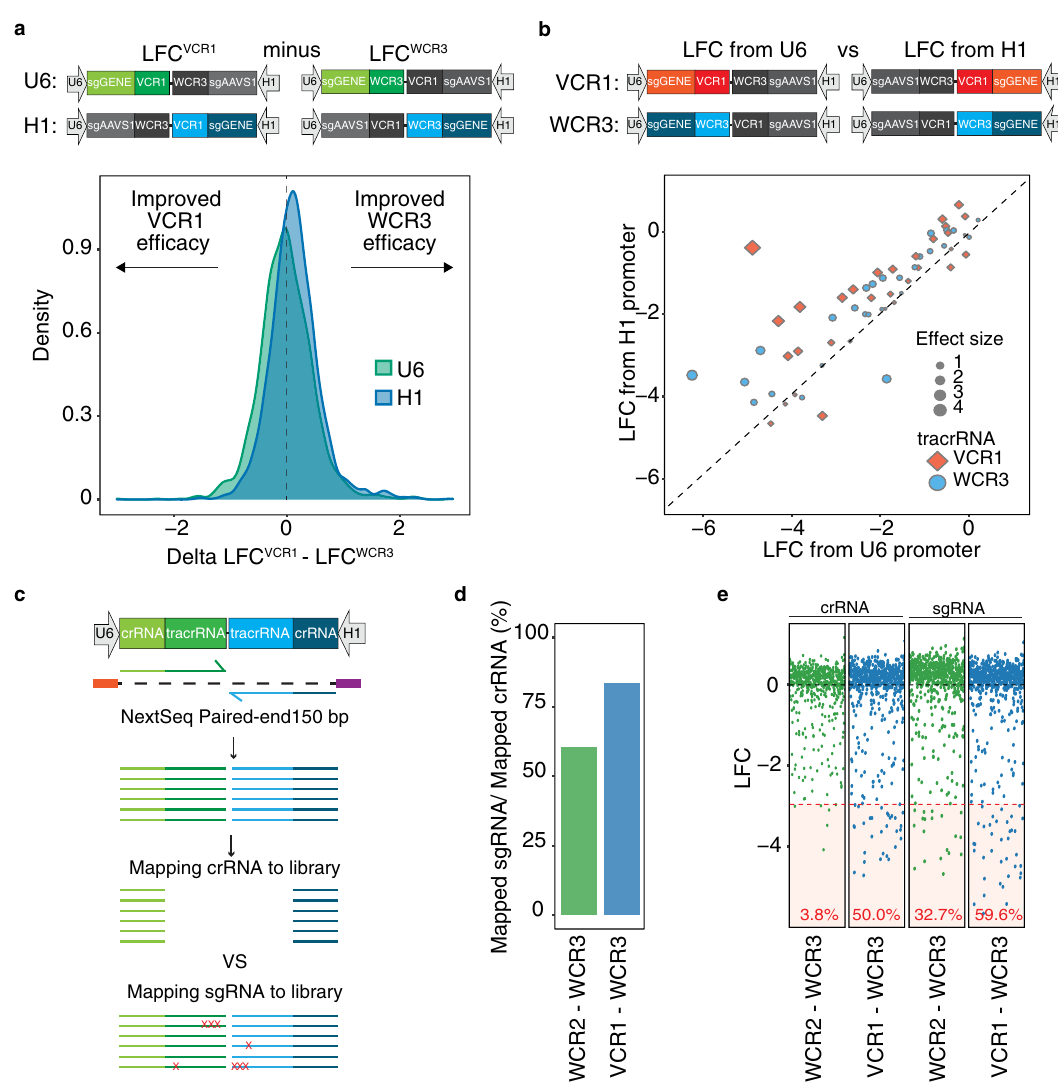
Fig. 3 Positional effects and recombination rate on gene targeting. a Evaluation of tracrRNA effect calculated by the difference in LFC between sgRNAs utilizing the VCR1 and WCR3 tracrRNAs from the VCR1-WCR3 and WCR3-VCR1 screens in IPC298. Analyses separated by promoters expressing the sgRNA. b Evaluation of the promoter effect by correlation between the LFC from the U6 and H1 promoter. For ten genes, same crRNA sequences are used on both left and right position to remove crRNA variability. Analyses separated by tracrRNA used. c Schematic illustration evaluating the recombination rate by next-generation sequencing (NGS) reads. crRNA and tracrRNA in both positions were sequenced by NextSeq paired-end 150 bp. Reads were either mapped to crRNA only or crRNA + tracrRNA (sgRNA). d Recombination rate calculated by percent of reads mapped between sgRNA to crRNA in pDNA for WCR2-WCR3 (green) and VCR1-WCR3 (blue). e LFC calculated by reads mapped to crRNA or sgRNA. The percentage of pan-essential genes with LFC less than − 3 are indicated in red. Source data are provided in the Source Data